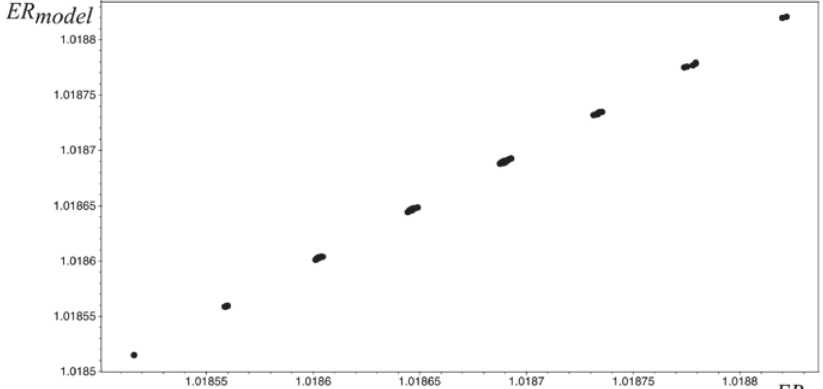
Figure 2. The correlation between the ER-values of chemical trees with 10 vertices and the values of ER calculated using eq.